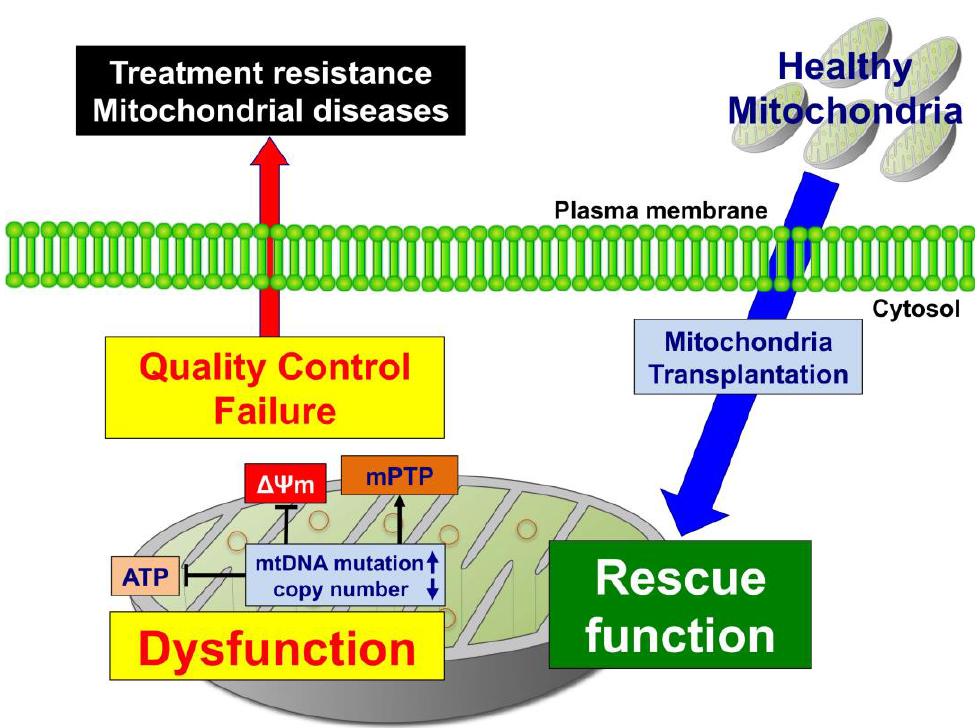
Figure 3. Mitochondria transplantation (mtTP) is a candidate strategy designed to rescue mitochondrial quality control failure. Mitochondrial dysfunction induced by mtDNA mutation or a decrease in mtDNA copy number leads to a decrease in ATP production, a decrease in mitochondrial membrane potential ( ∆Ψ m), and opening of the mitochondrial membrane permeable transition pore (mPTP). This mitochondrial quality control failure induces treatment resistance and mitochondrial disease. Mitochondrial quality control failure may be rescued by transplantation of healthy mitochondria.